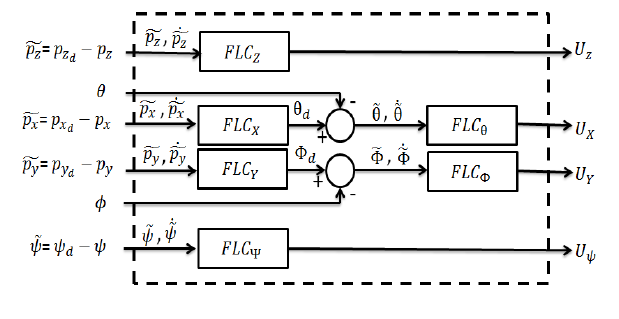
Figure 4. Flight control block diagram.